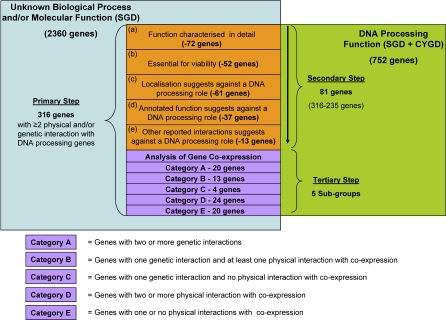
Integration of Datasets to Select Genes with Roles in DNA ProcessingSee text and Figure S1 and Tables S1, S2, and S3 for details of the selection strategy.